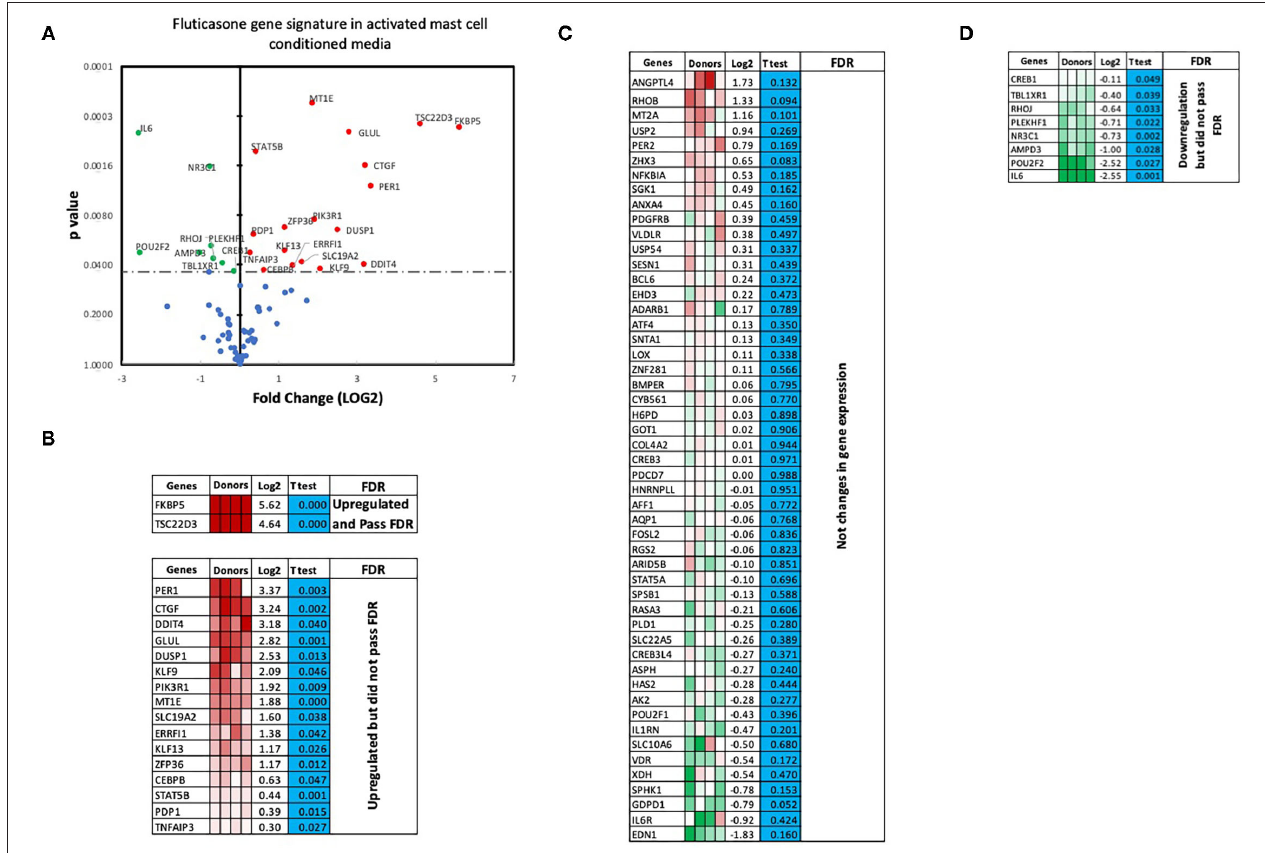
FIGURE 6 | Volcano plot and heatmap of fluticasone inducible genes in ASM cells detected using the PCR array in cells pre-treated with activated mast cell conditioned media. Data are presented as statistical significance ( p -value) vs. fold change (log2 fold) on the y-axis and x-axis, respectively, in response to 100nM fluticasone for 6h in ASM cells first pre-treated with control mast cell media (A) . All genes were normalized to housekeeping genes (GAPDH and beta-actin and presented as fold Change (2 − 11 Ct , log2 fold). (B) Genes upregulated that did pass or did not pass FDR, (C) genes with no expression change, and (D) genes that were downregulated but did not pass FDR. Student’s t -test was used for statistical significance. All the data ( p -value) were then adjusted using the False Discovery Rate approach (FDR) with a cut off P <